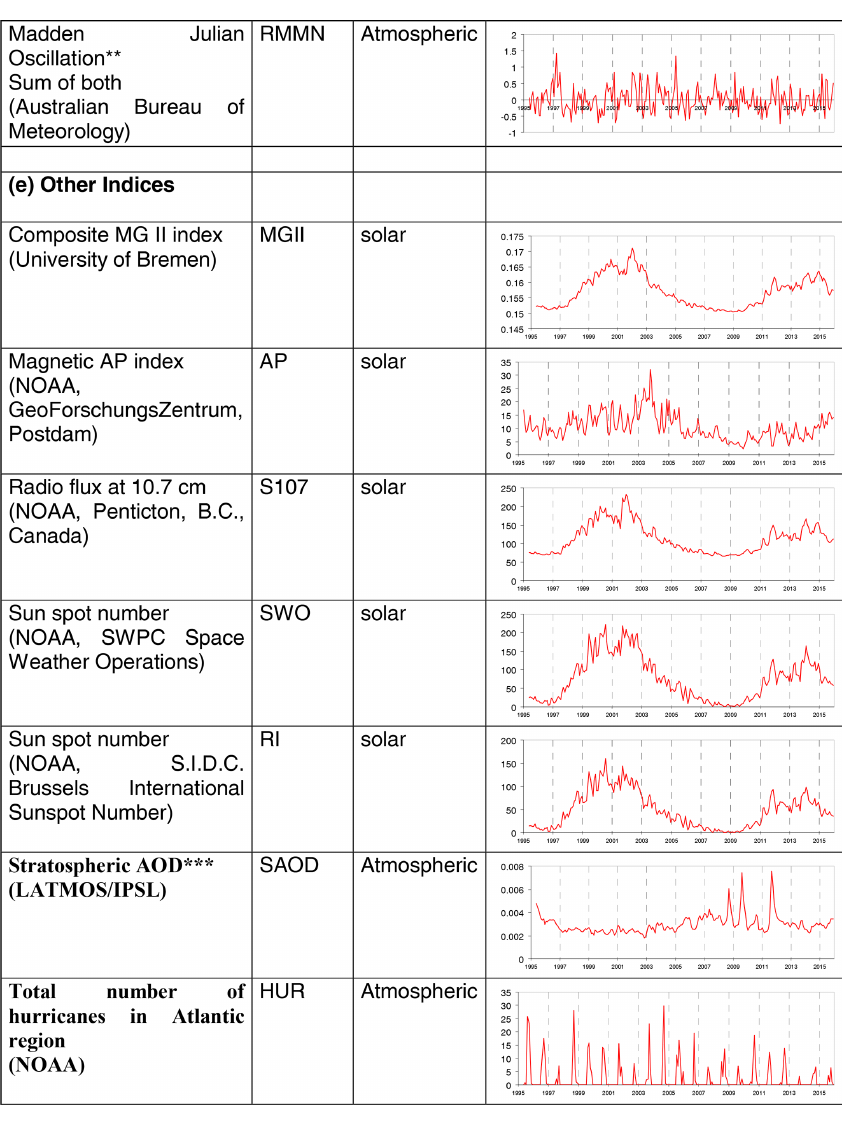
Figure A6. List of original indices used in this study. Besides the short names also the data sources and their temporal variation from 1995 to 2016 are shown. ∗ All MJO indices are convoluted with a Gaussian kernel of 30d FWHM. ∗∗ Original index according to Wheeler and Hendon (2004). ∗∗∗ Khaykin et al.